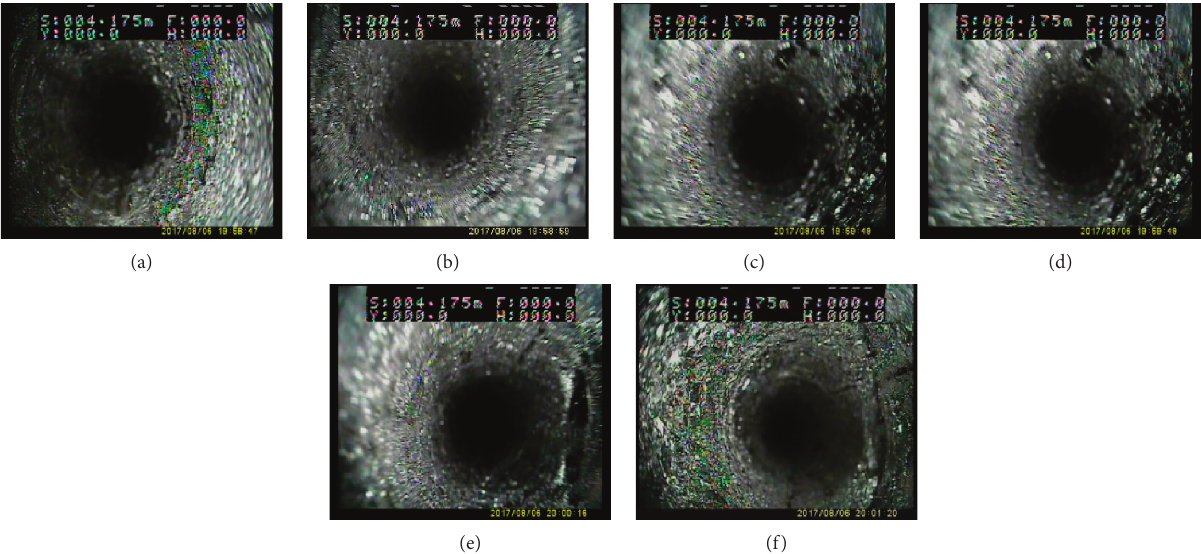
Figure 16: The distribution of the surrounding rock in the roof anchorage area. (a) 0.2m. (b) 0.7 m. (c) 0.8m. (d) 1.0 m. (e) 1.8 m. (f) 2.2m.